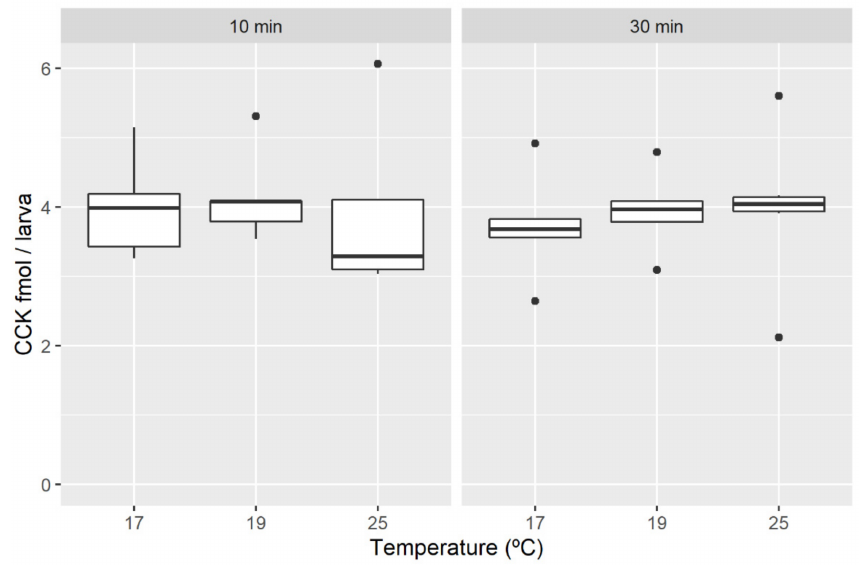
Figure 7. Variation in CCK levels in Sparus aurata larvae aged 41 days post-hatching, at 10 and 30 min after being fed at different water temperatures. Boxplot: black horizontal line represents the median, the lower and upper white boxes represent 1st and 3rd quartile, the inferior and superior extremes of whiskers represent minimum and maximum values, respectively, and the black dots represent outliers.